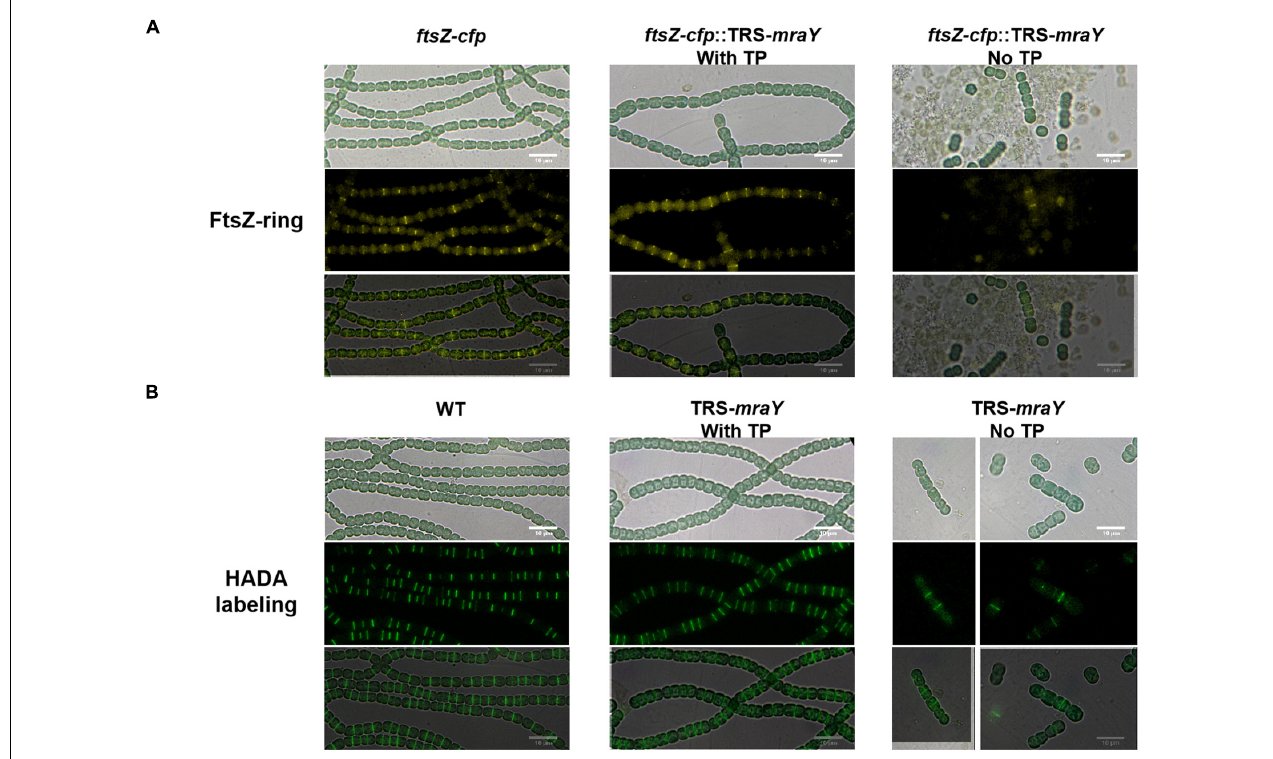
FIGURE 5 | FtsZ-ring formation and PG synthesis in TRS- mraY in BG11 under permissive and non-permissive conditions. (A) FtsZ-CFP is a CFP fluorescence fusion protein of FtsZ as already reported (Xing et al., 2021). Filaments of strain ftsZ-cfp :TRS- mraY grown in BG11 medium with 1 mM of TP were collected and transferred to BG11 medium without TP for 12 h ( Supplementary Figure 5 ) to remove TP. Then they were incubated for 24 h in BG11 without TP to observe FtsZ localization. (B) Strain TRS- mraY was first treated similarly to remove TP ( Supplementary Figure 5 ), then incubated for 24 h with 150 µ M of HADA in BG11 without TP to observe PG synthesis pattern. WT was used as the control. TABLE 1 | FtsZ-ring formation and PG synthesis pattern in the wild type (WT) and strain TRS- mraY . Strains and conditions (TP: mM) Midcell (%) Cell-cell junction (%) FtsZ-ring